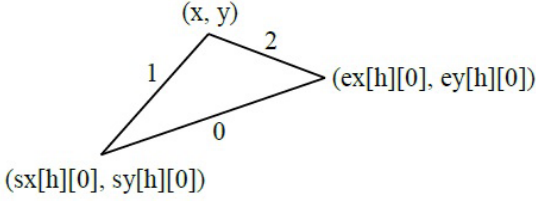
Figure 5: Non-collinear with the 0 th edge.